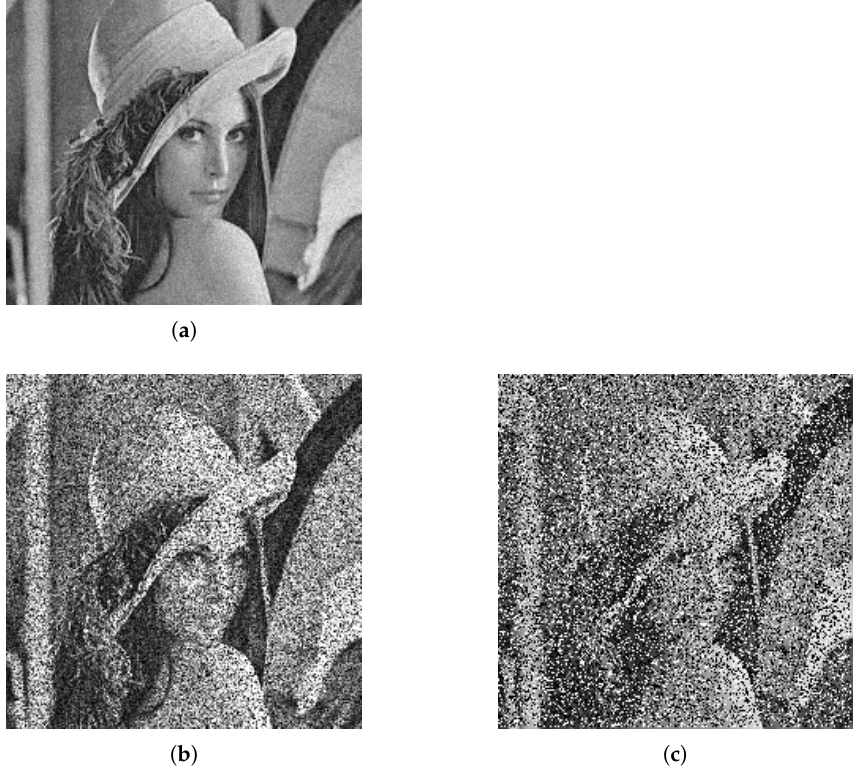
Figure 6. Noisy image corrupted with Gaussian noise ( a ), speckle noise ( b ), and salt-and-pepper noise ( c ). It is hard to differentiate speckle noise from salt-and-pepper noise by the human